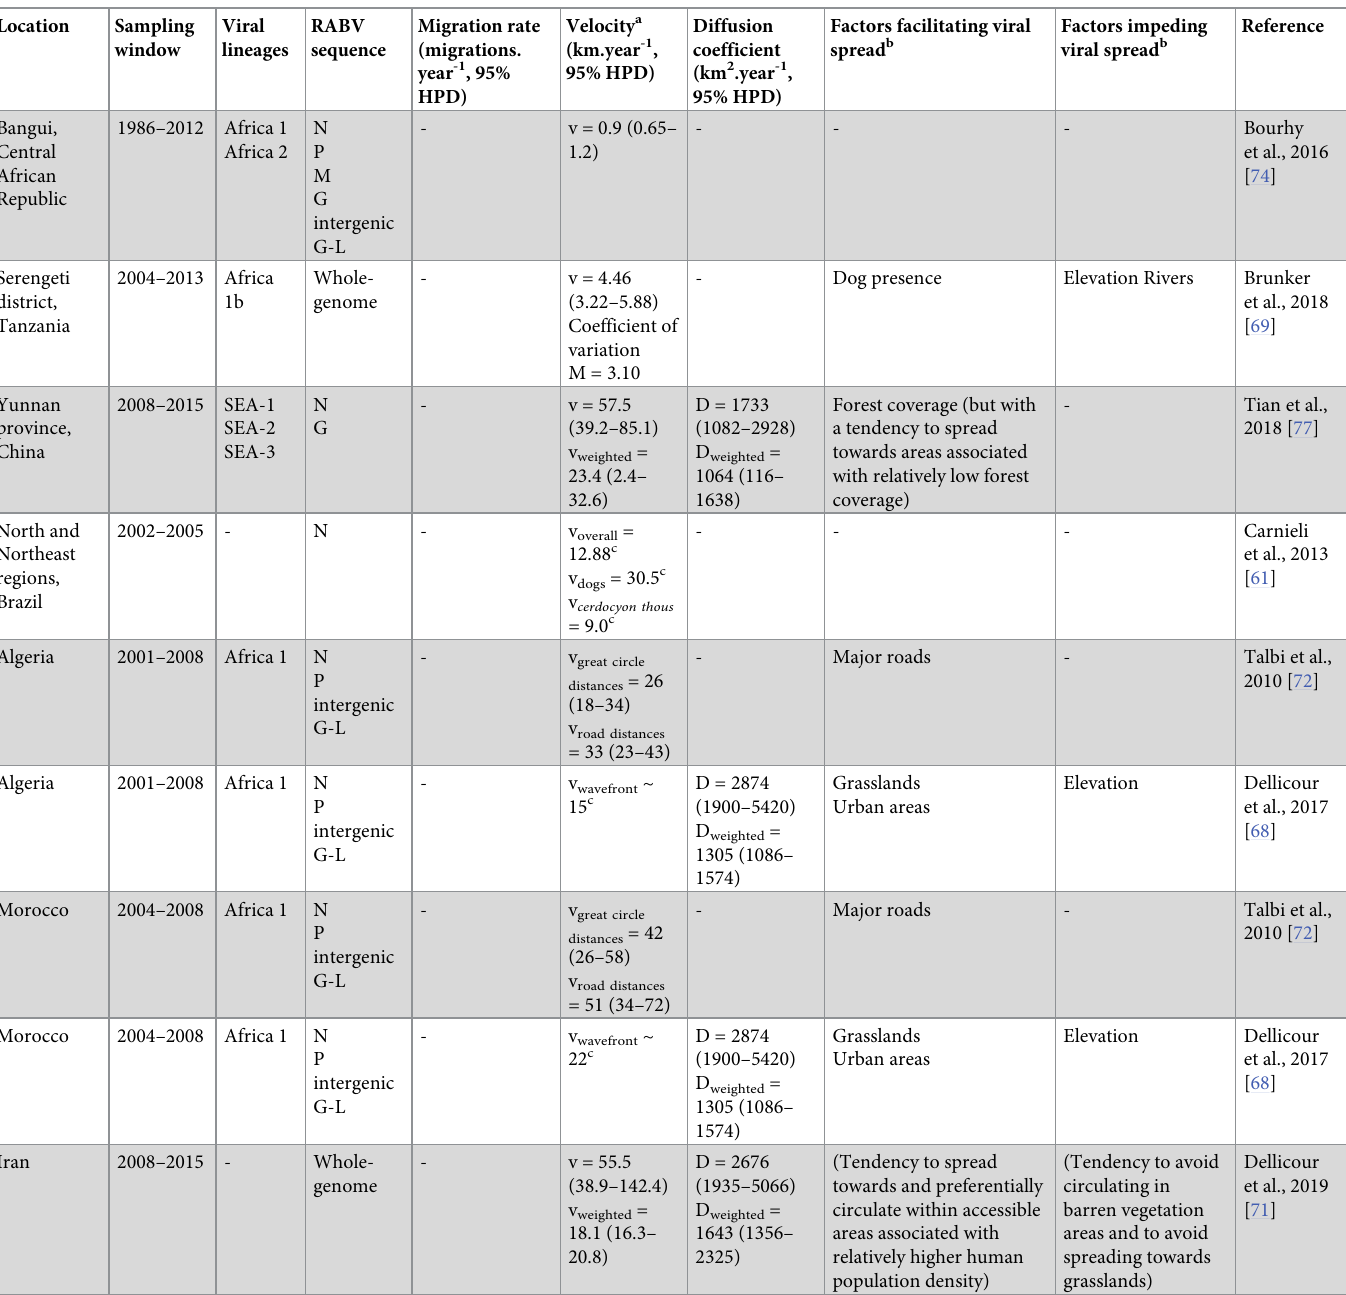
Table 1. Estimated parameters in phylodynamic